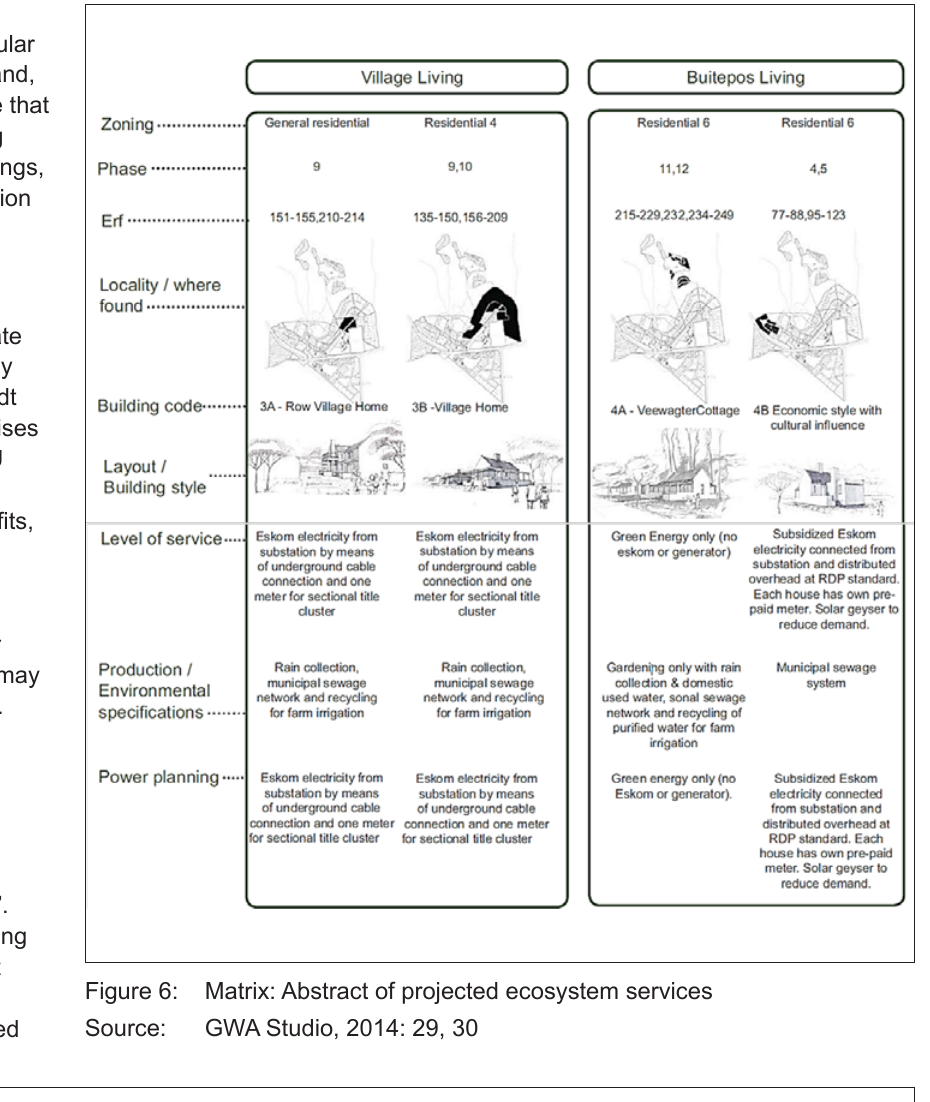
Figure 6: Matrix: Abstract of projected ecosystem services